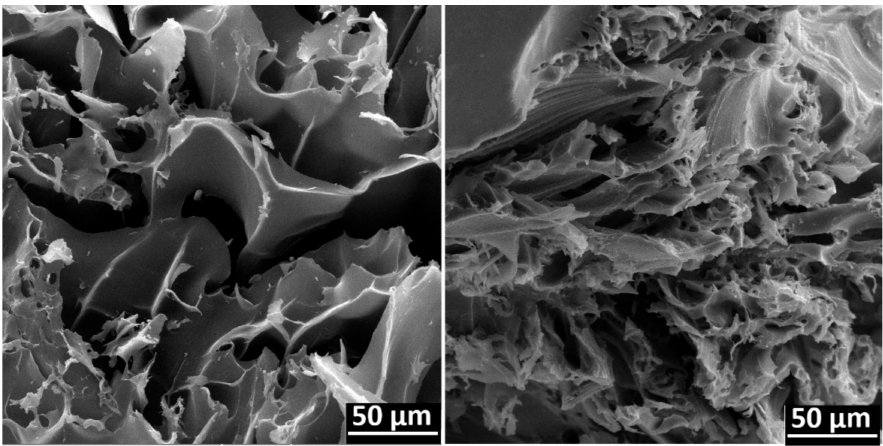
Figure 7. SEM micrographs of net -CS ( left ) and ( net -CS)- g -NVCL/AAc 32% grafts ( right